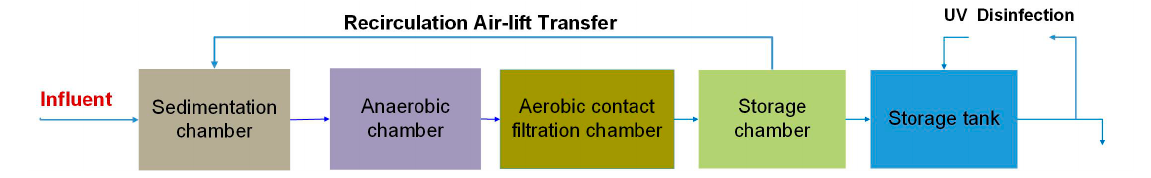
Figure 2. Block flow diagram of the on-site treatment process.